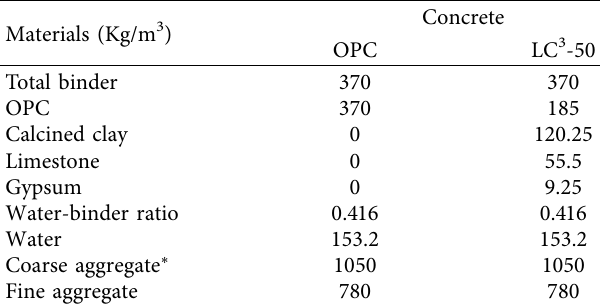
Figure 1: Particle size distribution of LC 3 -50 and OPC. Table 2: Mix design of OPC and LC 3 -50 concrete sample con- sidered in this